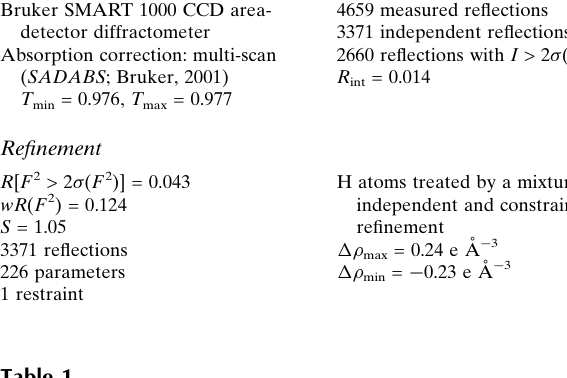
Hydrogen-bond geometry (A˚ , (cid:2)